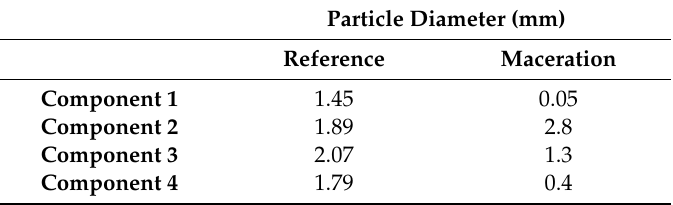
Table 3. Overview of particle sizes in the reference process and the maceration.